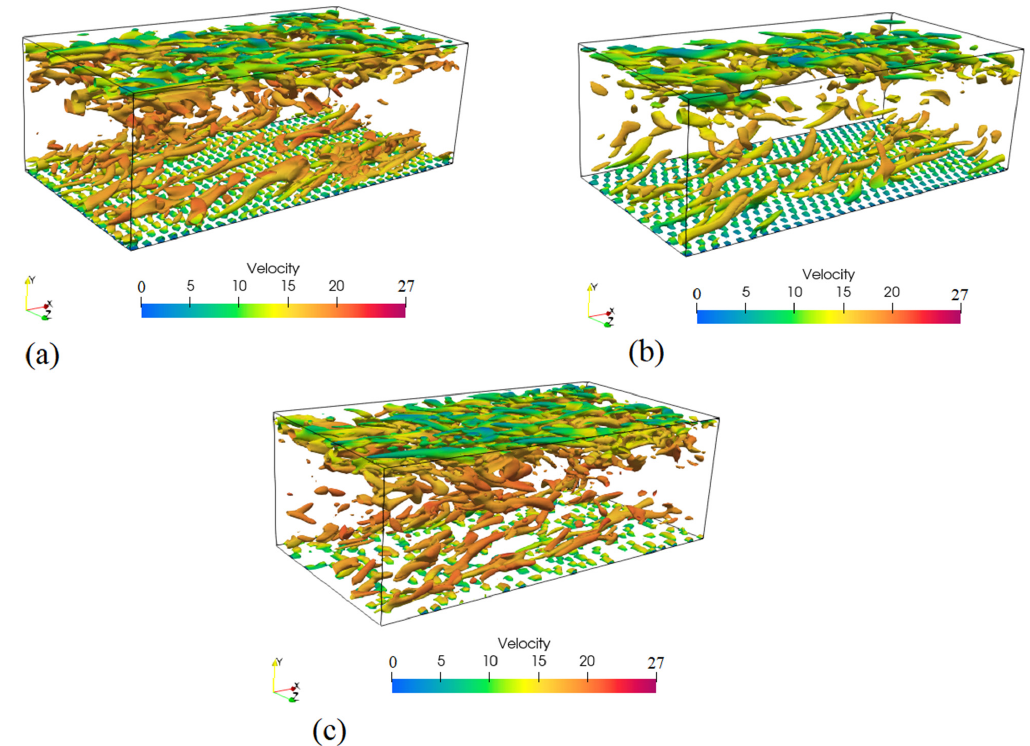
Figure 18. Vortex core isosurface (Q = 200) contour of the superhydrophobic surface with φ s = 1 : ( a ) aligned, ( b ) staggered, and ( c ) random.